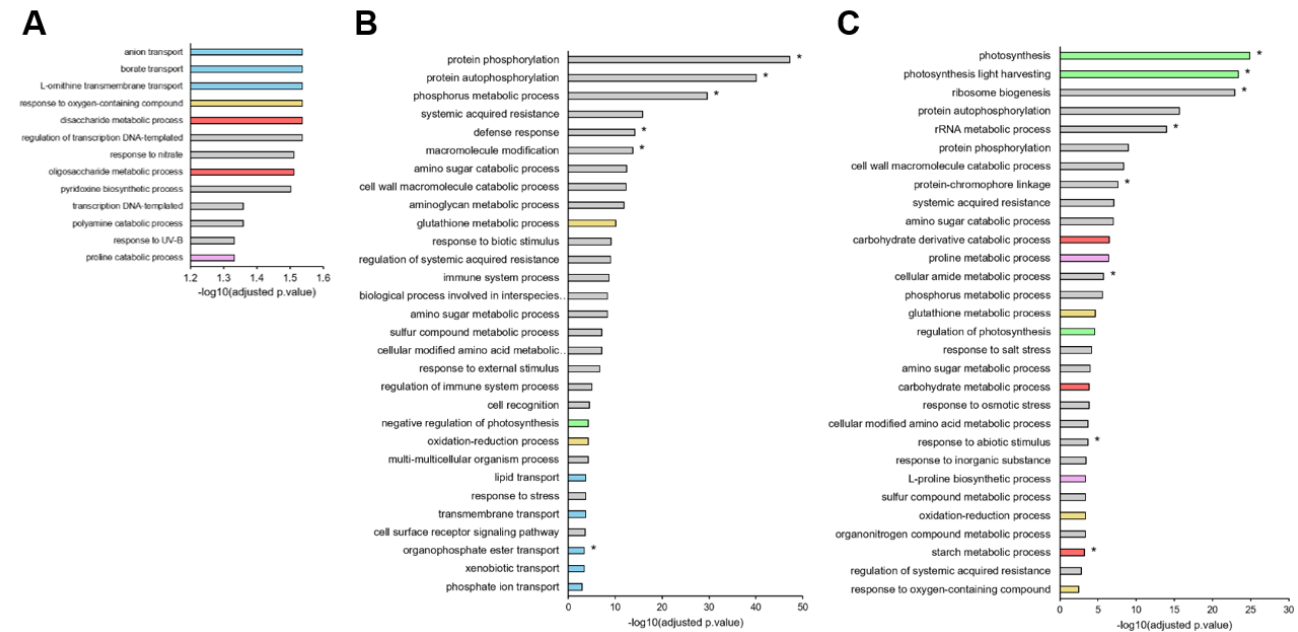
Figure 3. The most significantly enriched GO terms ( “ biological process ” ) from DEGs in leaves of B. napus exposed to 5 d (mild) ( A ), 11 d (severe) ( B ), and 20 d (severe and extended) ( C ) of water deficit. GO terms associated with transport (blue), redox homeostasis (gold), carbohydrate (red), and proline (pink) metabolism as well as photosynthesis (green) are highlighted, and terms enriched from specific DEGs at each time point are indicated with an asterisk (*).